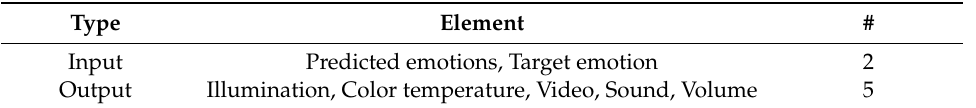
Table 9. Input and output of stimulus decision